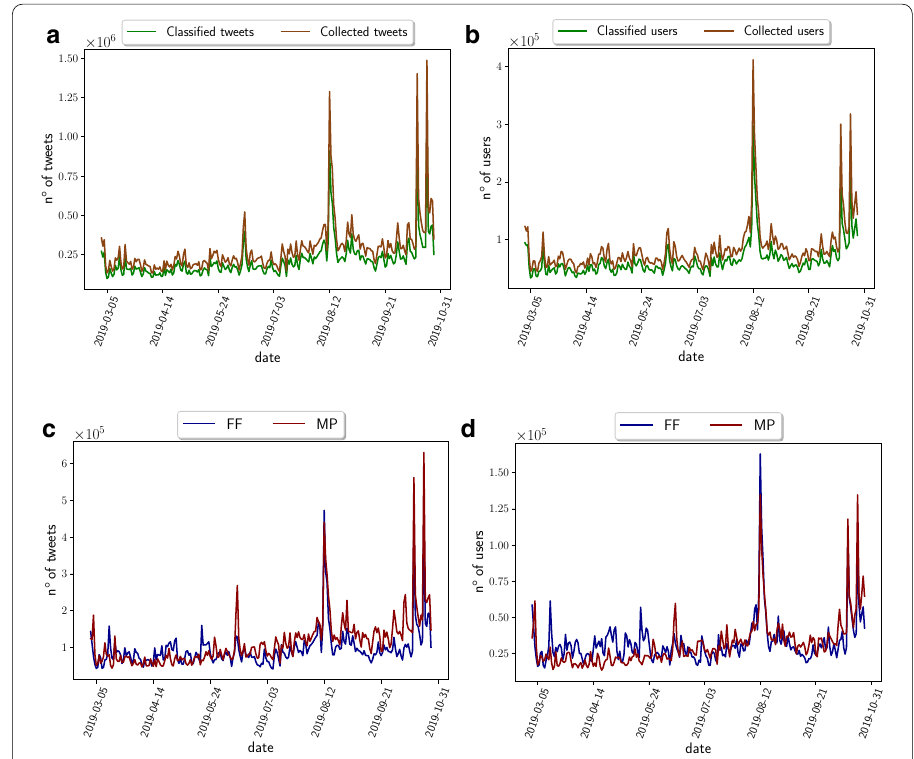
Fig. 5 a Daily volume of collected (brown line) and classified (green line) tweets. b Daily volume of collected (brown line) and classified (green line) users. c Daily tweets supporting the FF and MP formula. d Daily